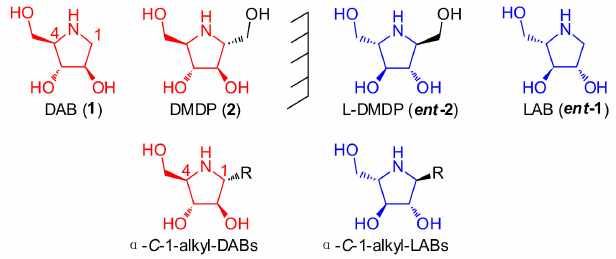
Figure 1. Structures of DAB, DMDP, and their related derivatives.